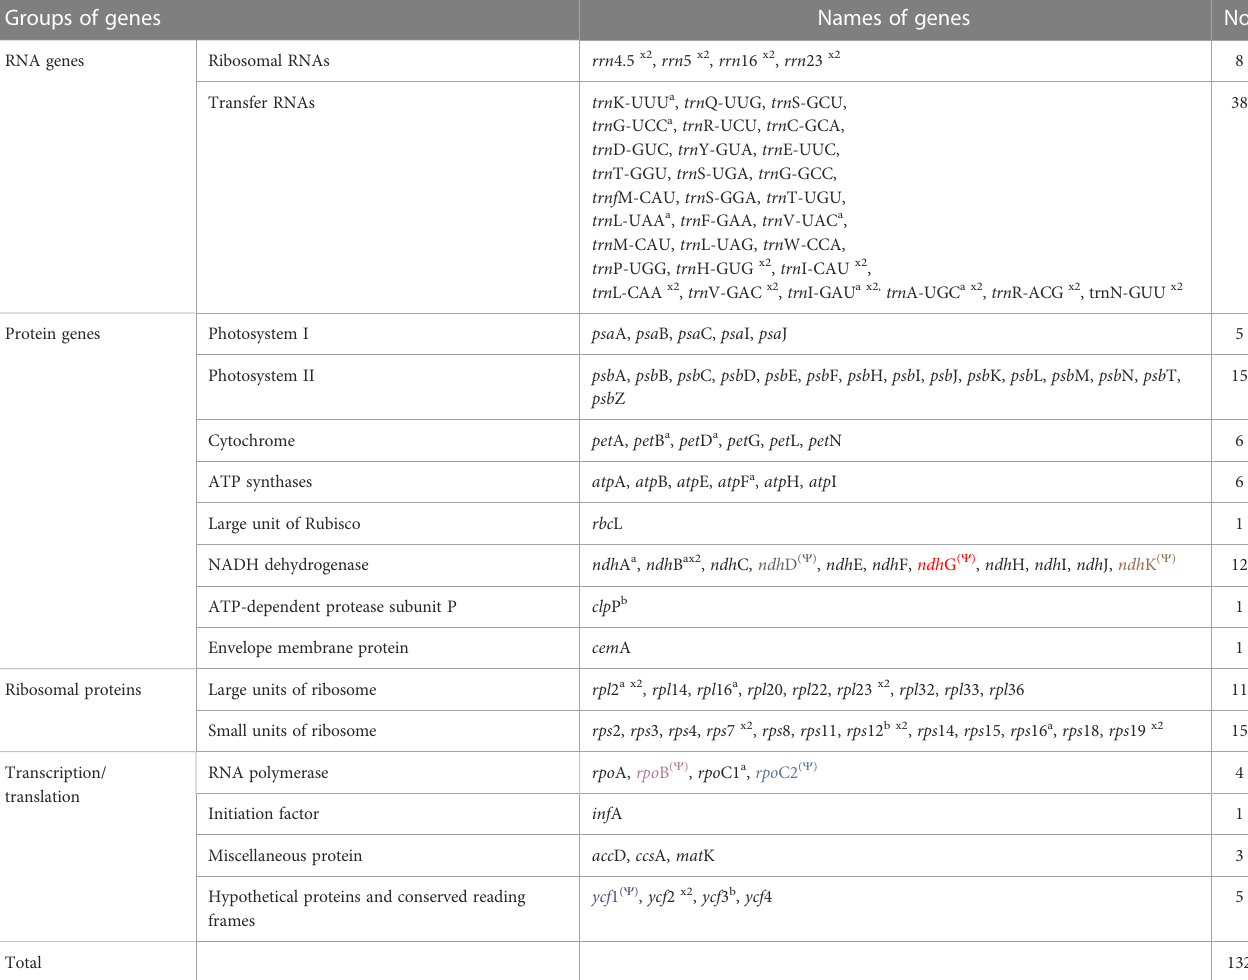
TABLE 3 Gene composition within chloroplast genomes of Iridaceae species. Groups of genes Names of genes No. RNA